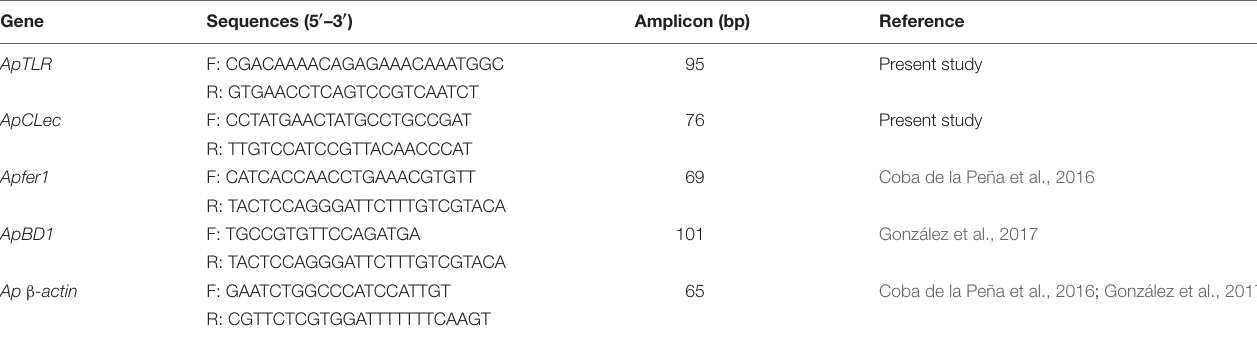
TABLE 1 | Nucleotide sequences of the primers used for RT-qPCR of immune and housekeeping genes in Argopecten